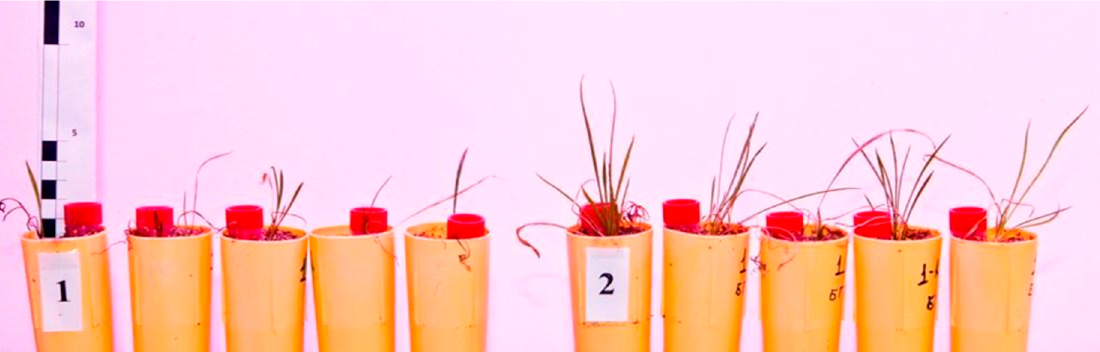
Figure 4. Seedlings of S. tau-saghyz without vermicompost (1) and with 20% vermicompost (2) after 172 days of growth.